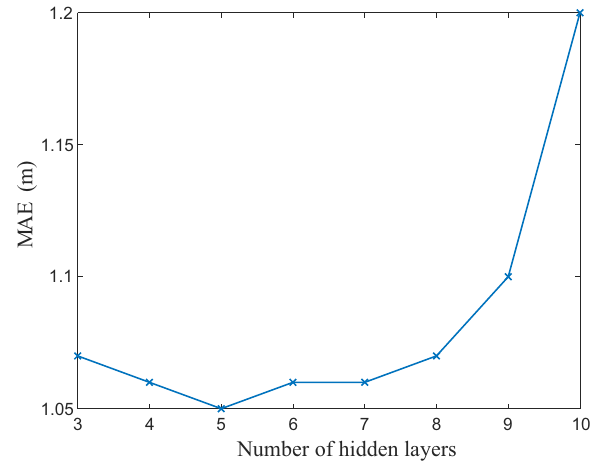
Figure 6. MAE of interpolation using ANNs for different numbers of hidden layers